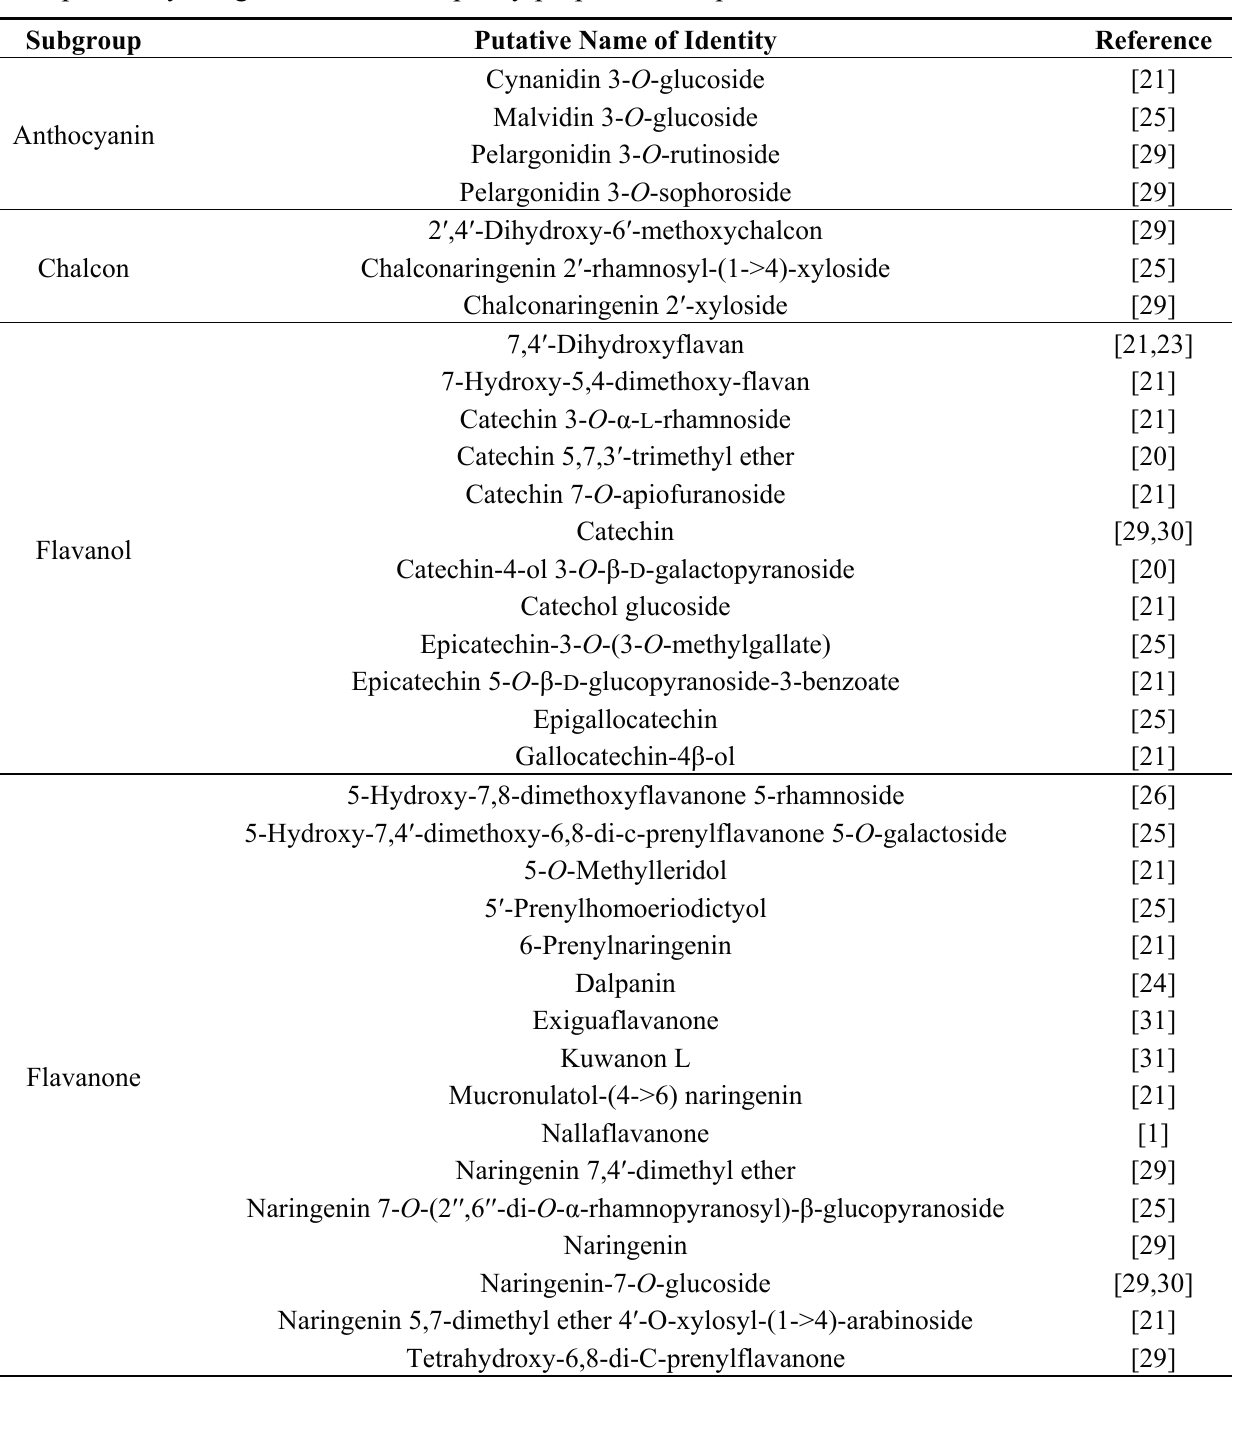
Table 2. Metabolites pinpointed for their potential contribution to FHB resistance and putatively assigned to flavonoid phenylpropanoid